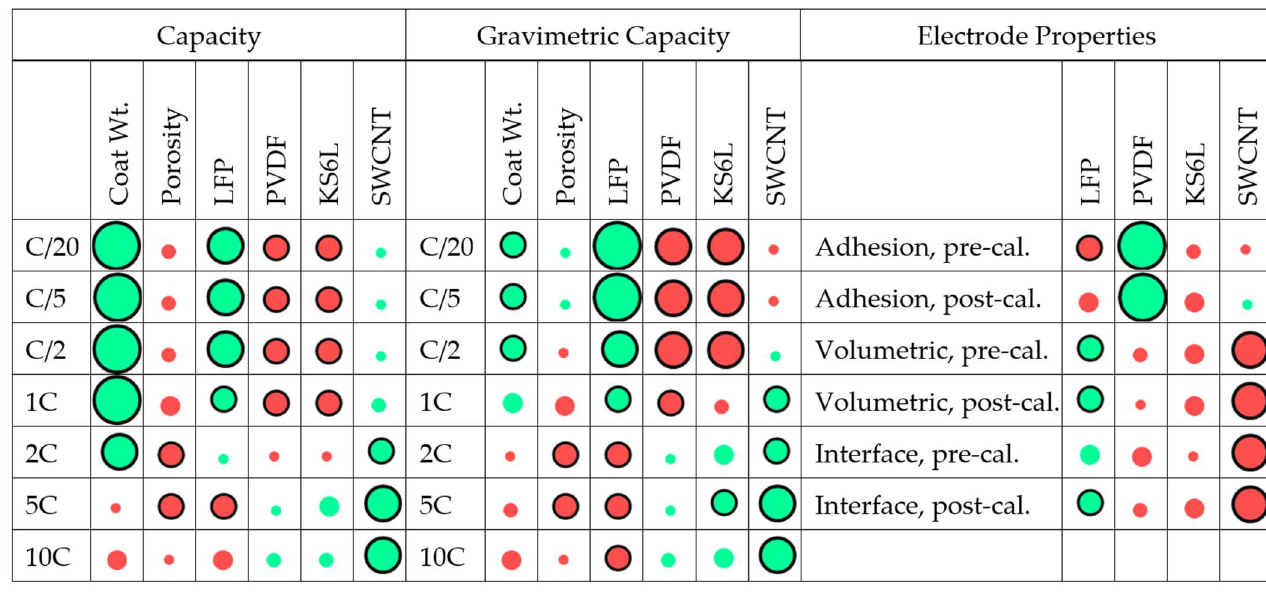
Figure 4. Pearson’s coefficients for cell capacity, gravimetric capacity, and electrode properties.